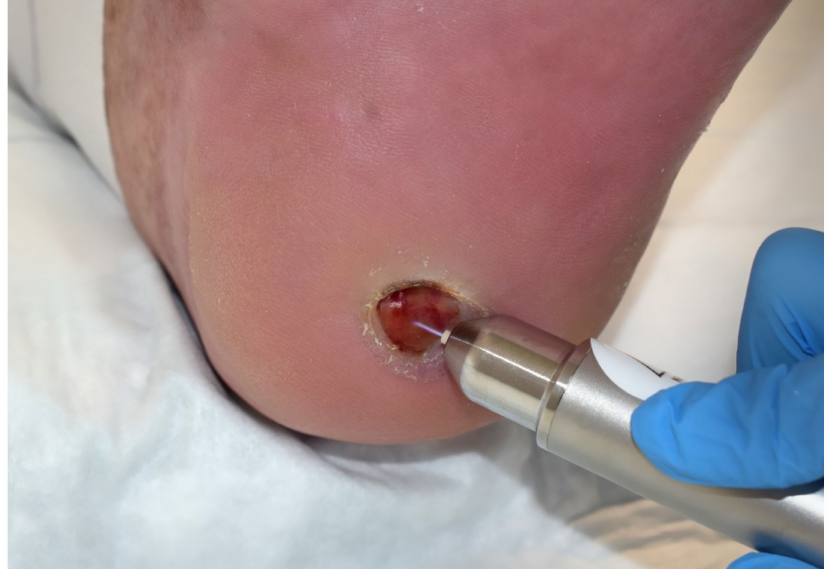
Figure 3. Application of the plasma jet device kINPen ® MED (neoplas med GmbH, Greifswald, Germany) to a diabetic pressure ulcer on the foot. The advantage of the jet device is plasma transduction into deeper wound areas and into wound